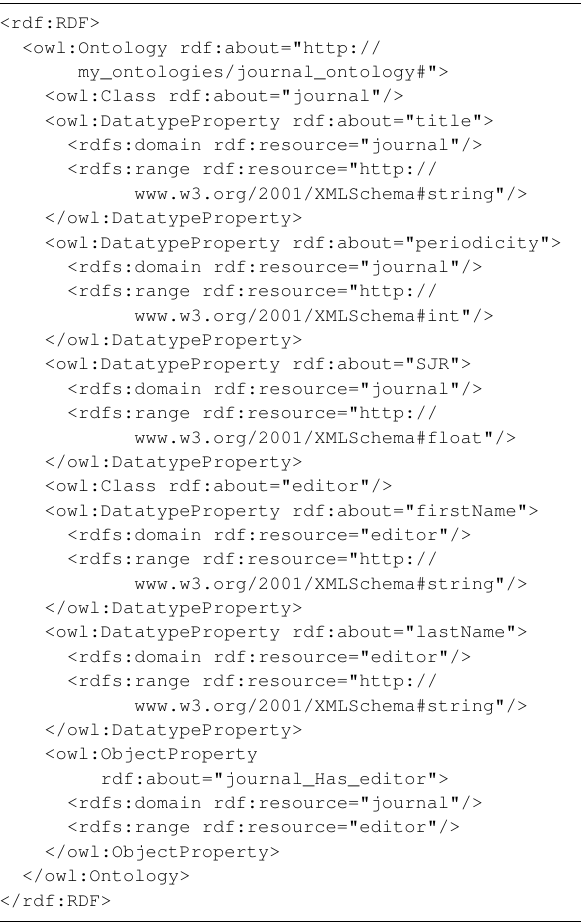
Fig. 9 The generated OWL 2 ontology of journals (“JournalsOntology V1.owl”) on June 01, 2021.